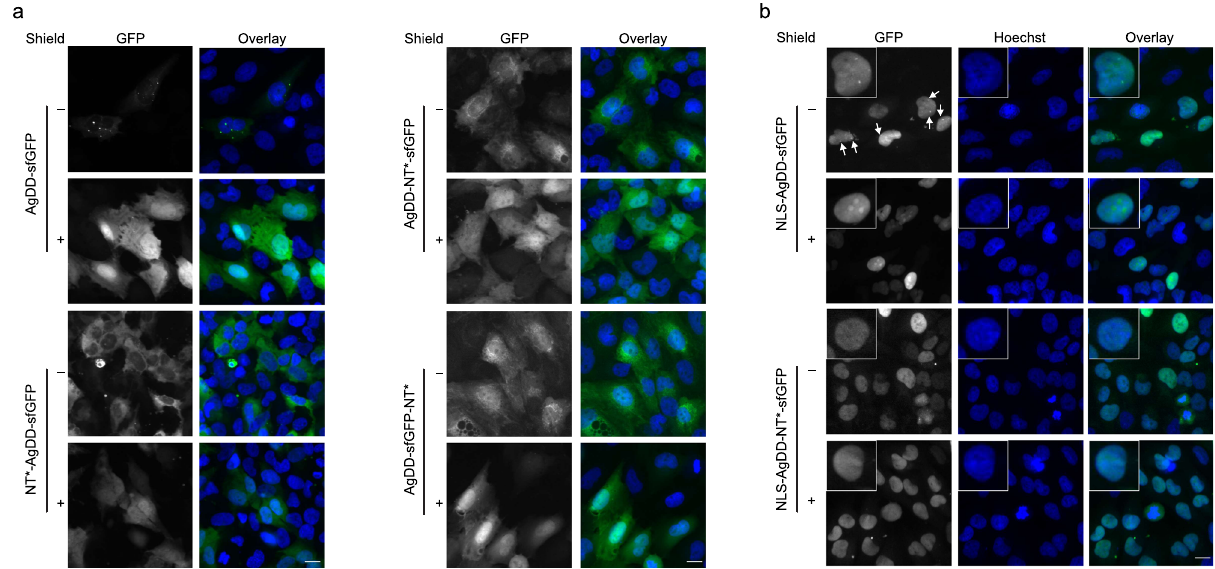
Fig. 4 Effect of NT* domain on AgDD aggregation in DAOY cells. a DAOY cells stably expressing AgDD-sfGFP, NT*-AgDD-sfGFP, AgDD-NT*-sfGFP or AgDD-sfGFP-NT* in the absence or presence of 1 µ M Shield-1 were fi xed in 4% PFA and counterstained with Hoechst. Scale bar is 20 µ m. b DAOY cells stably expressing NLS-AgDD-sfGFP or NLS-AgDD-NT*-sfGFP in the absence or presence of 1 µ M Shield-1 were fi xed in 4% PFA and counterstained with Hoechst. Scale bar is 20 µ